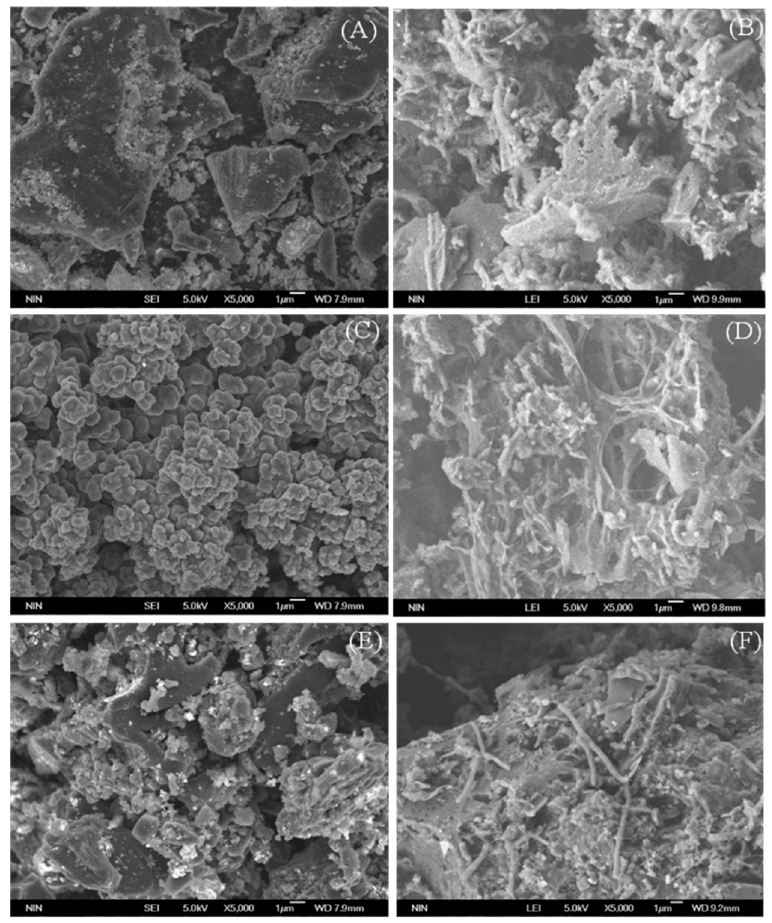
Figure 7. SEM graphs of different adsorbents before ( A , C , and E ) and after ( B , D , and F ) the bioreactor operation. ( A , B ) are of GAC adsorbents; ( C , D ) are of PPy adsorbents; and ( E , F ) are of 0.2-PPy/GAC adsorbents.